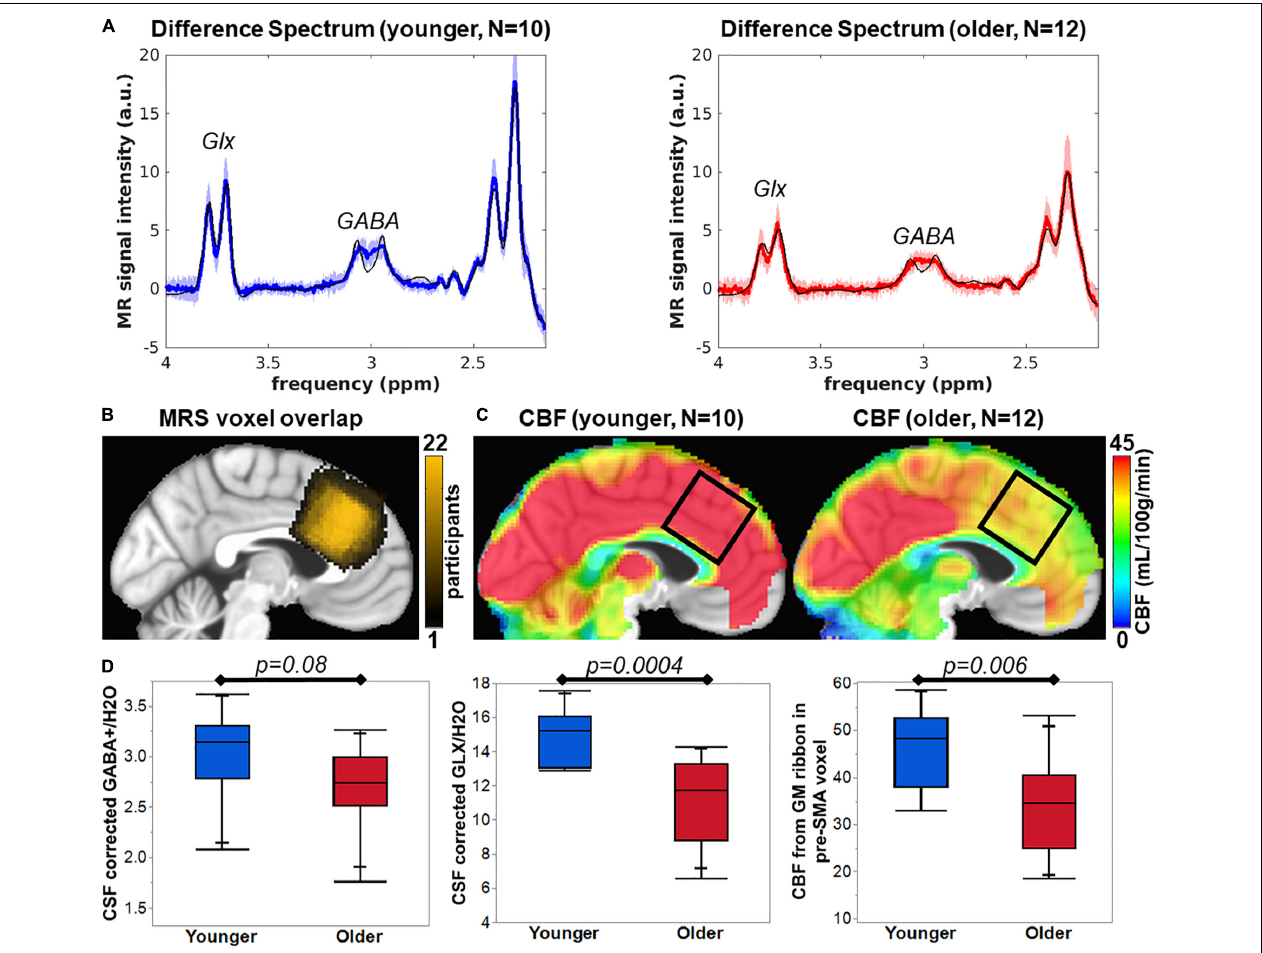
FIGURE 1 | (A) Average difference spectra for younger (blue line) and older cohorts (red line) with shaded region representing standard deviation of the group spectra. The thin black line shows the average LCModel fit. (B) MRS voxel overlap in pre-SMA across N = 22 participants (color bar represents the overlap of number of participants). (C) Average CBF maps for younger and older participants with black square indicating pre-SMA region that corresponds to the MRS voxel location. (D) The bar plots of group comparisons for CSF corrected GABA+/H2O (institutional units), CSF corrected Glx/H2O (institutional units), and CBF from the gray matter ribbon in the MRS voxel (mL/100g/min).